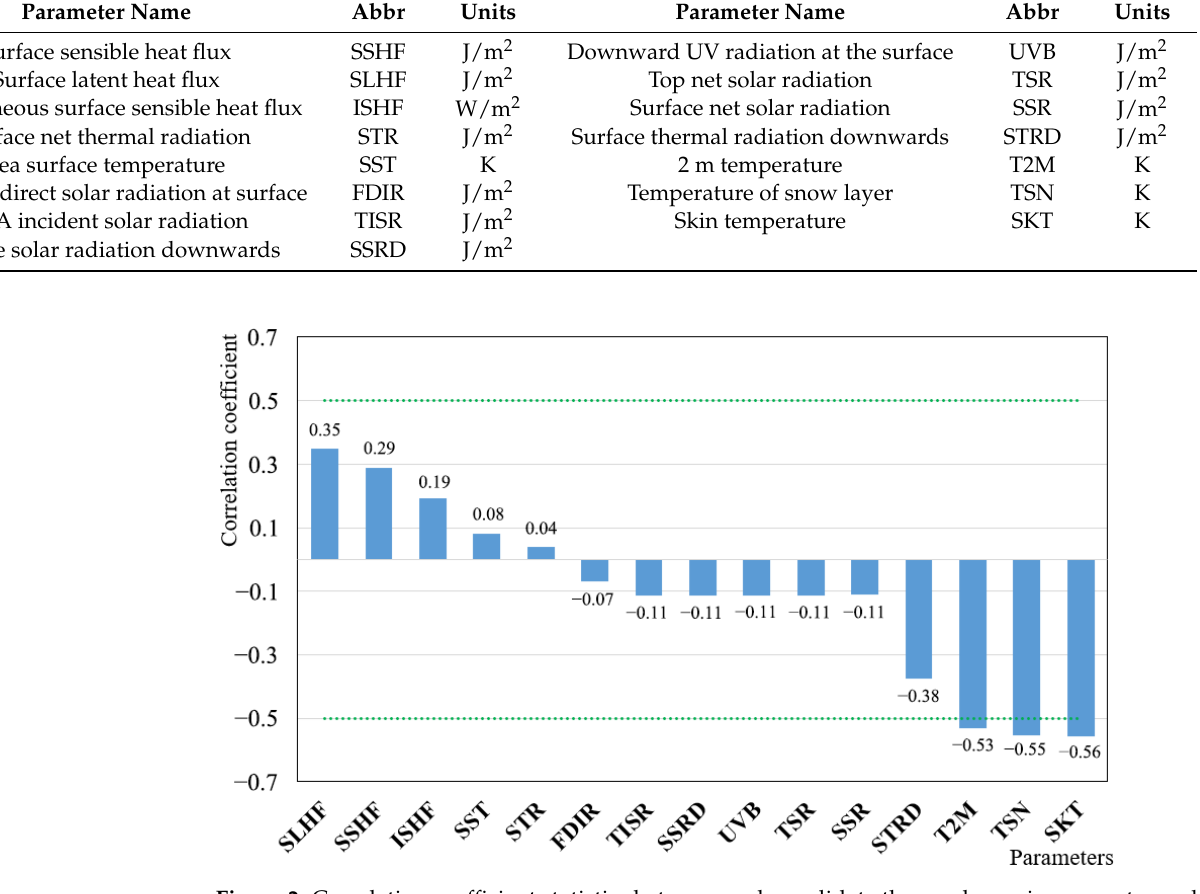
Figure 2. Correlation coefficient statistics between each candidate thermodynamic parameter and Arctic winter SIT.